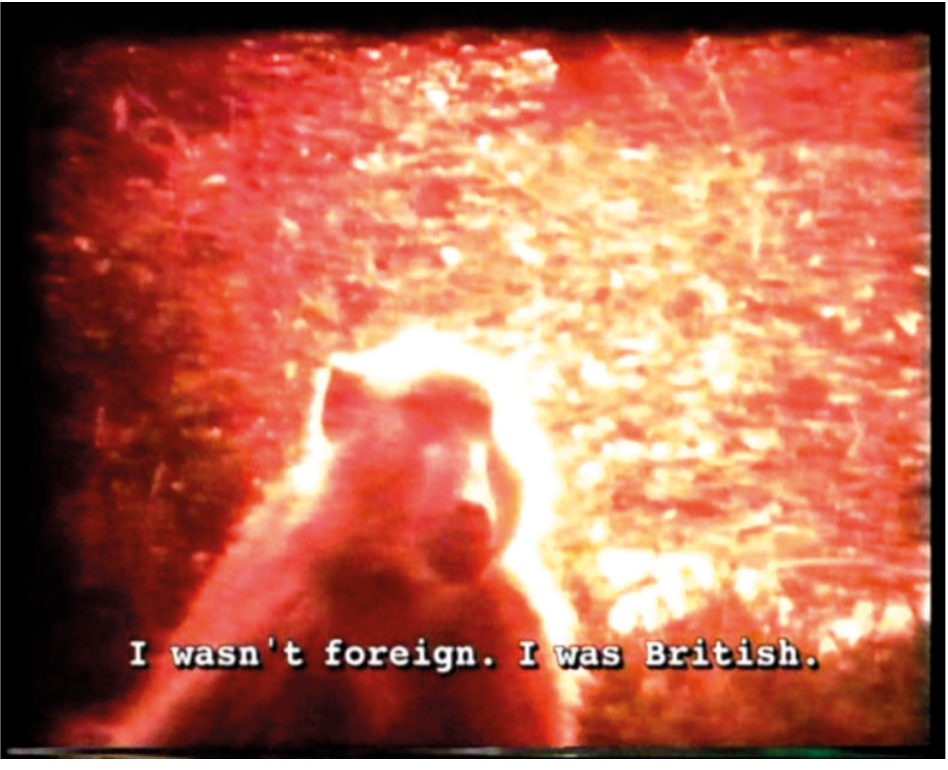
Figure 10 Penny Siopis, My Lovely Day (film still), 3 rd ed., 1997. Video installation of mini cinema and 8mm film transferred to video, 21 minutes. Museum of Modern Art, Stockholm; South African National Gallery, Cape Town; the artist (photo: courtesy Penny Siopis and Stevenson Gallery, Cape